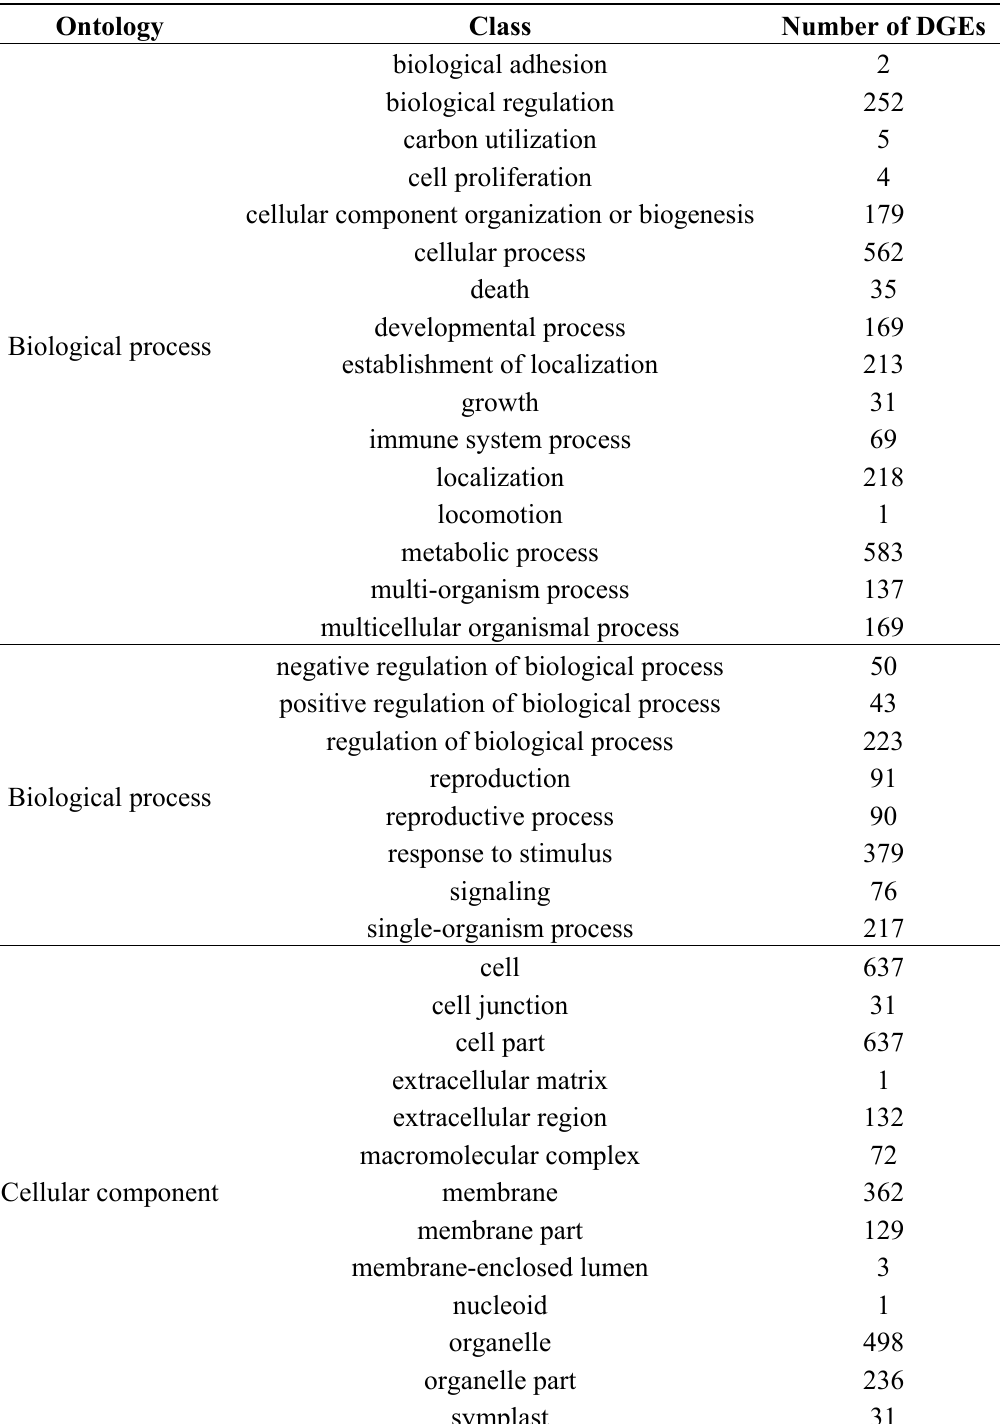
Table 2. Statistical analysis of the biological process, cell component and molecular function of the differentially expressed genes ( DEG s) in both the PA2T vs. PA2 and PA4T vs. PA4